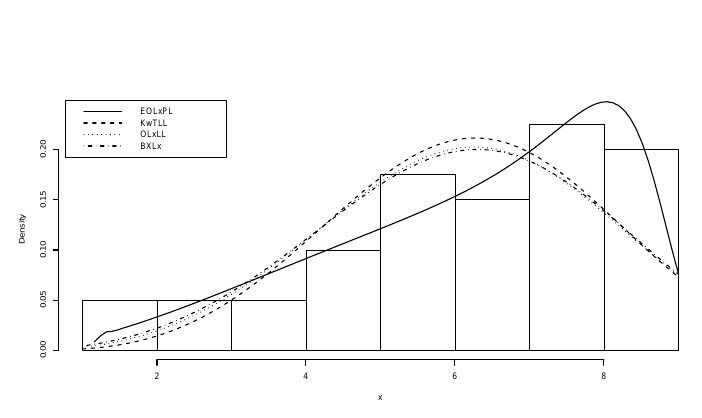
Figure 6 – The estimated densities of EOLxPL, KwTLL, OLxLL and OP distributions.